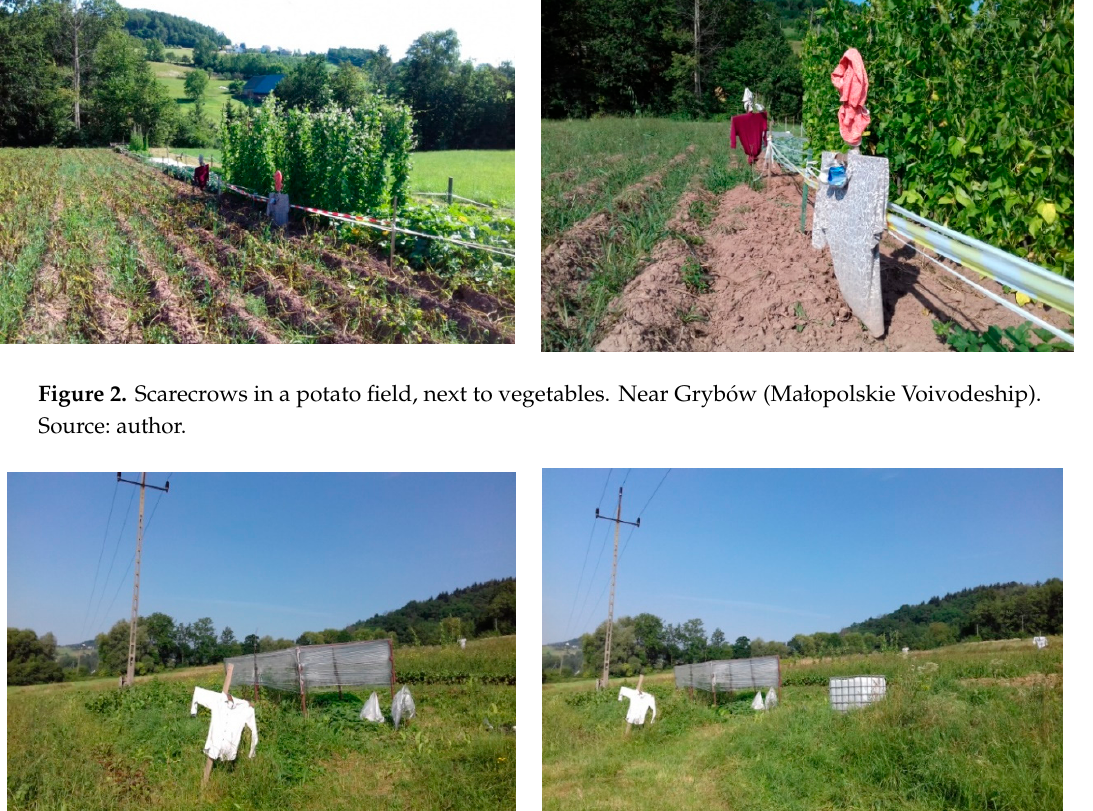
Figure 3. Scarecrows in a vegetable patch. Household cultivation. Near Gryb ó w (Małopolskie Voivodeship). Source: author.